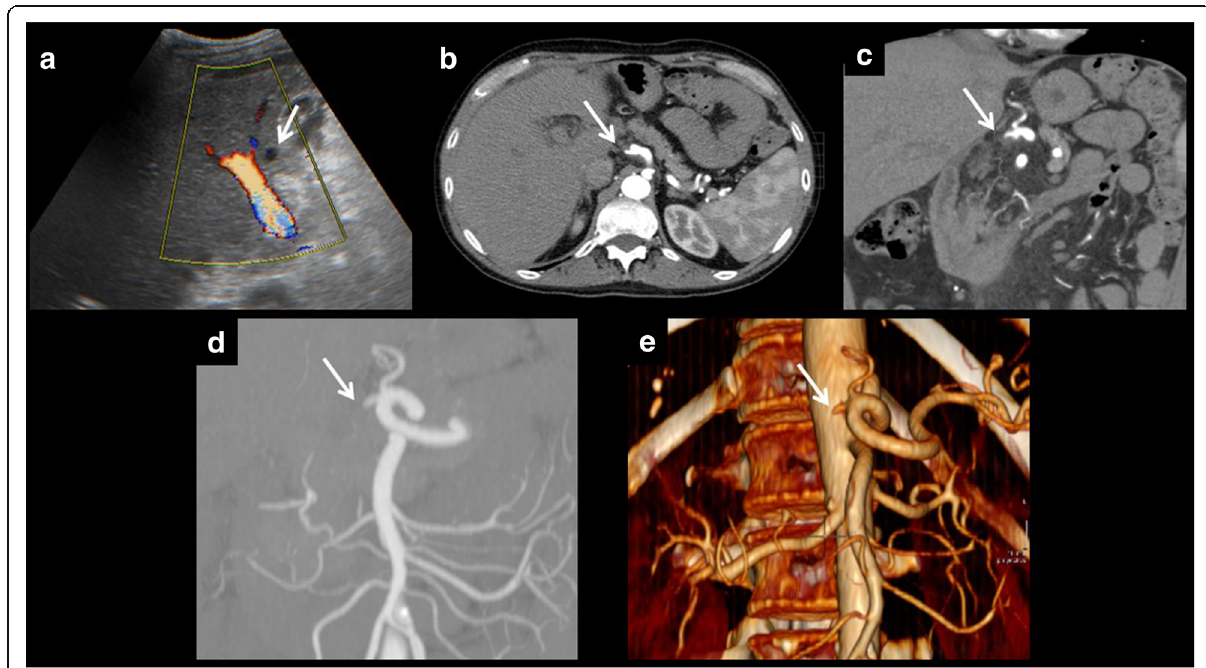
Fig. 2 Anastomotic thrombosis. Artery thrombosis is the most serious complication of orthotopic liver transplantation. It can be demonstrated as an absence of flow in Doppler ultrasound examination ( a ). CT can depict the thrombus and also the absence of distal flow ( b ).